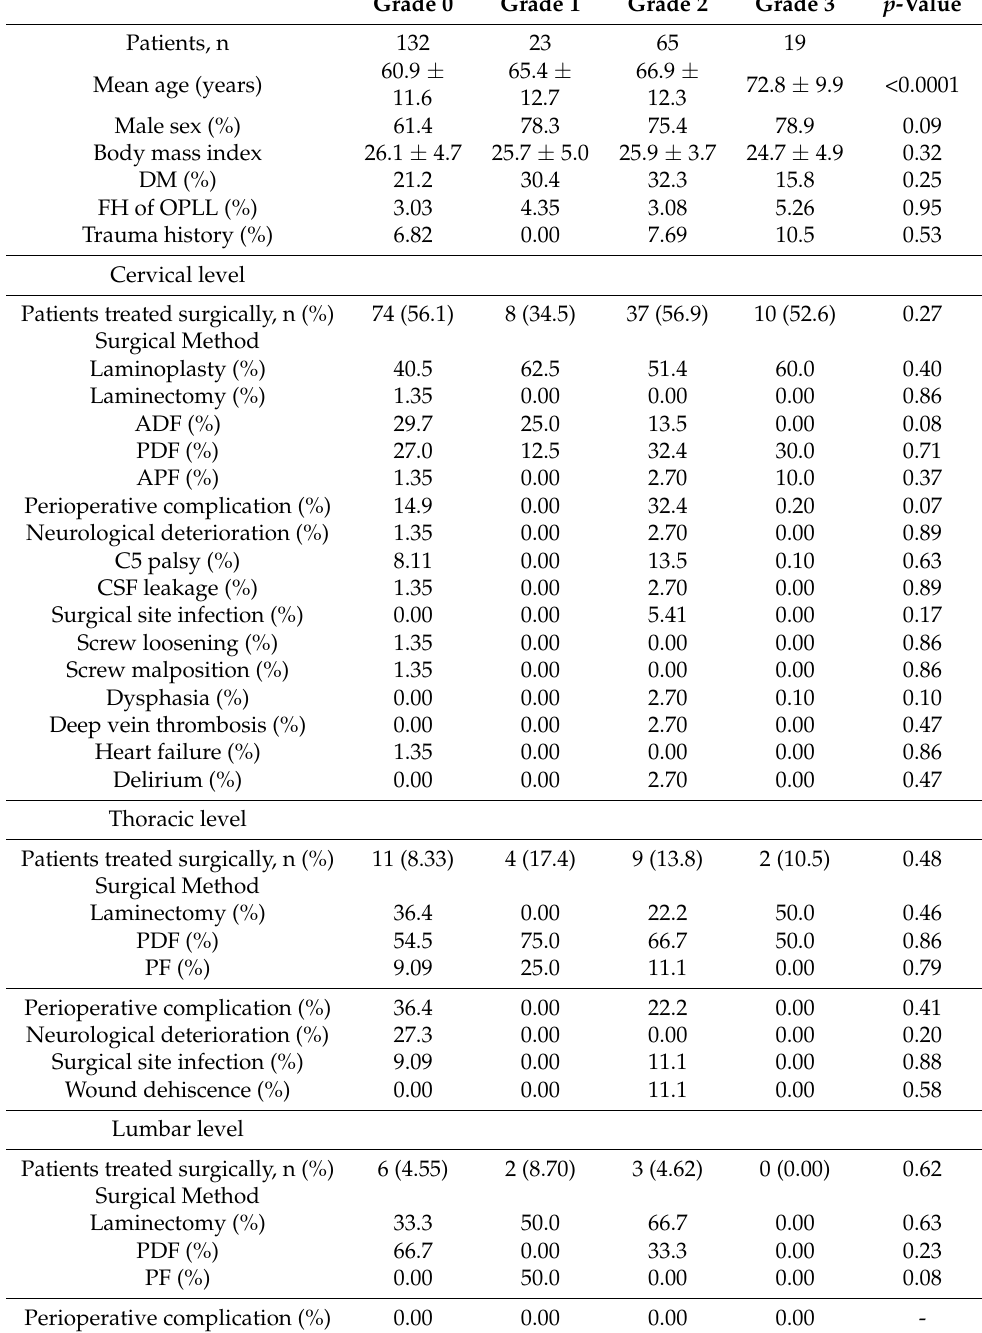
Table 1. Demographic data and surgery-related data for each DISH